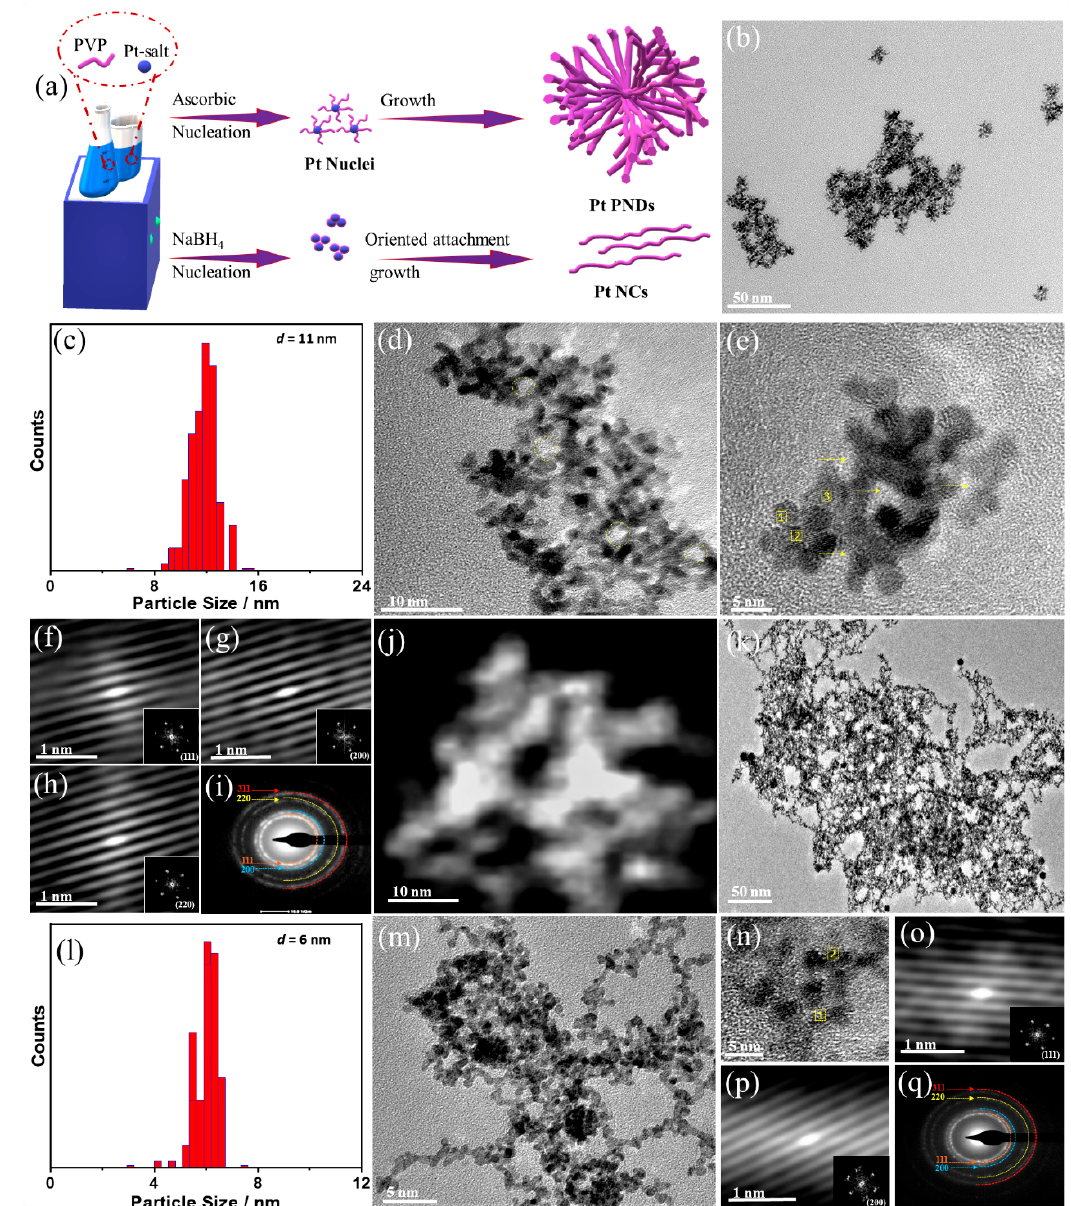
Figure 1. ( a ) Schematic illustration of the preparation process of Pt NDs and Pt NCs. ( b ) TEM image, ( c ) particle size distribution, ( d ) high-magnification TEM image, ( e ) HRTEM of Pt NDs, and ( f – h ) Fourier filtered HRTEM images of the numbered areas (1–3) in ( e ) respectively, ( i ) SAED, and ( j ) HAADF-STEM image of Pt NDs. ( k ) TEM images, ( l ) particle size distribution, ( m ) high-magnification TEM image, ( n ) HRTEM of Pt NCs and ( o ) SAED, and ( p , q ) Fourier filtered HRTEM images of the numbered areas (1–2) in ( n ), respectively, of Pt